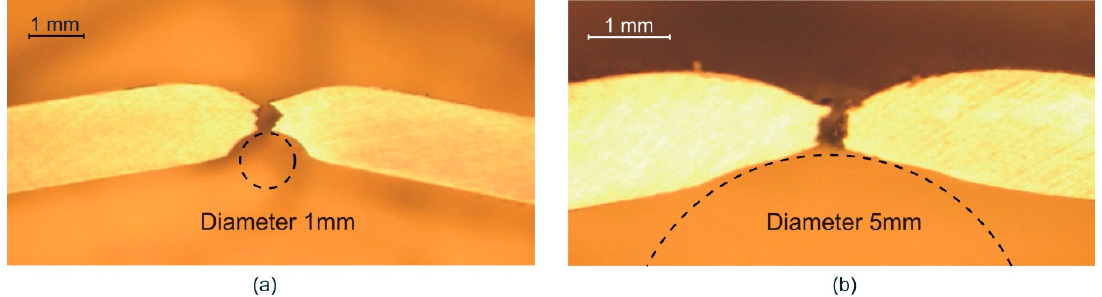
Figure 6. Cross section of AA7075-O specimens after fracture using cylindrical punches of ( a ) φ 1 mm and ( b ) φ 5 mm.